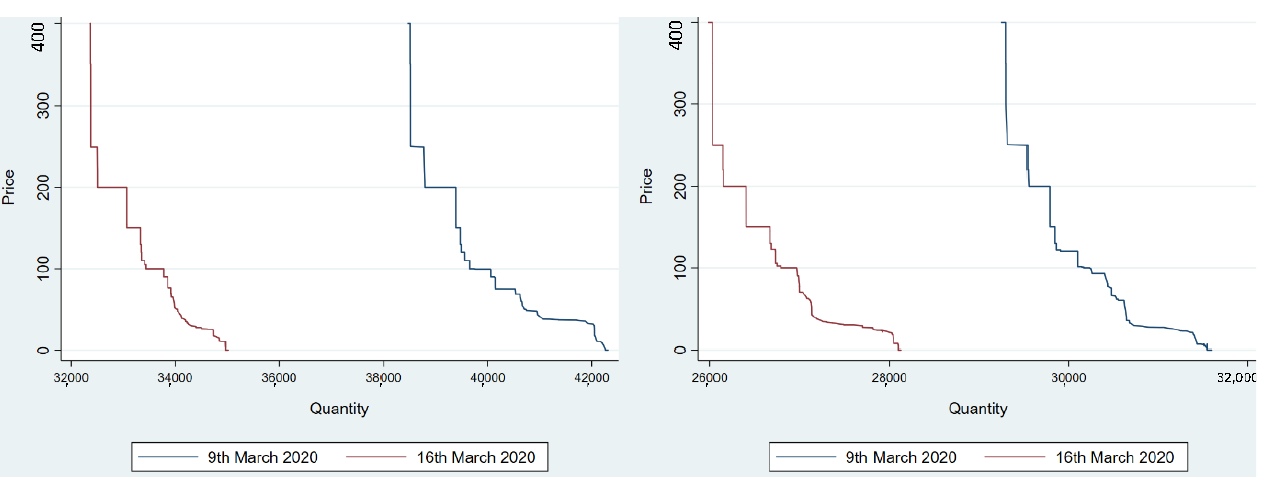
Figure 5. Relative Annual Variation (2020 vs 2019) of Market Equilibrium Prices (PUN)-Weekly Av- erage.